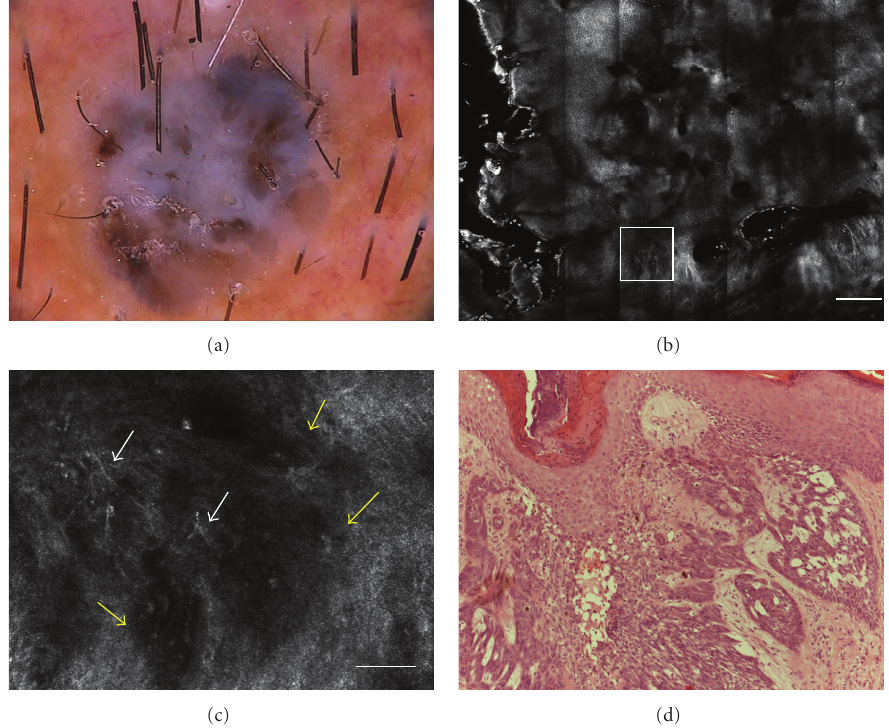
Figure 1: (a) Dermoscopic image of nodular pigmented lesion showing a blue gray veil structureless brown areas and dark brown dots in the center (original magnification 30 × ). (b) RCM image (4 × 4 mm) at dermoepidermal level, showing a general cauliflower architecture highly specific for BCC diagnosis (scale bar: 500 µ m). (c) RCM image (0 . 5 × 0 . 5 mm, white frame), showing dark silhouettes ( yellow arrows ) outlined by dark spaces. In the inner portion of them, bright filaments were present ( white arrows ) (scale bar: 50 µ m). (d) Histology showing basaloid nodules in the dermis corresponding to hypopigmented dark silhouettes. Within and outside the tumor nests some melanin was present (H&E section; original magnification ×